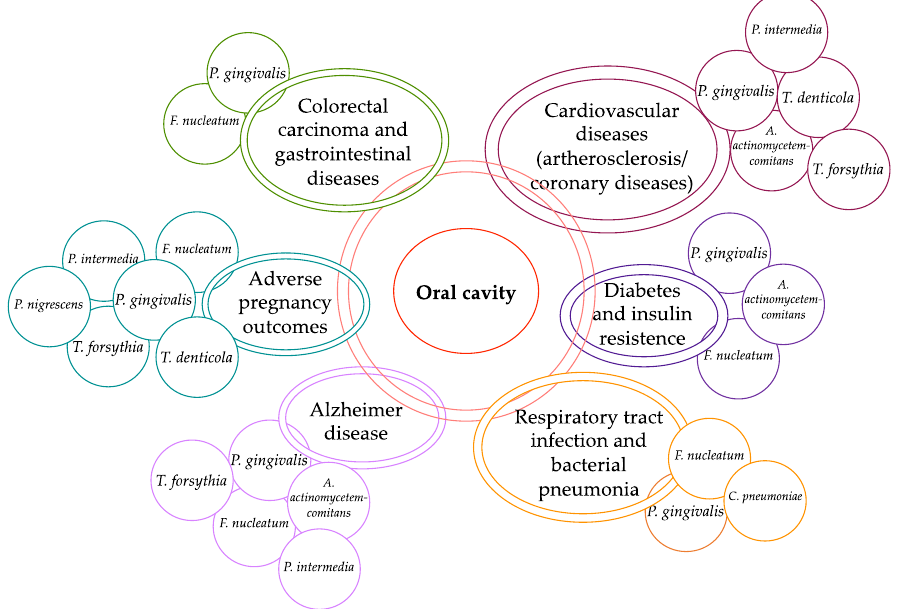
Figure 1. Schematic representation of different systemic diseases and their association with periodontal pathogens.